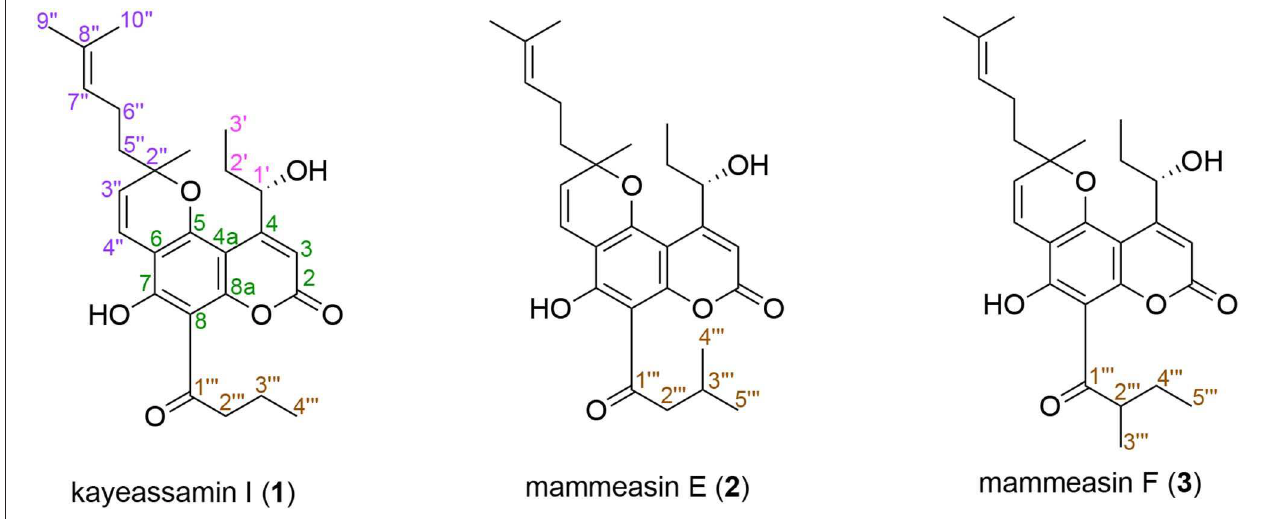
FIGURE 1 | Structures of kayeassamin I (1) and mammeasins E (2) and F (3) .